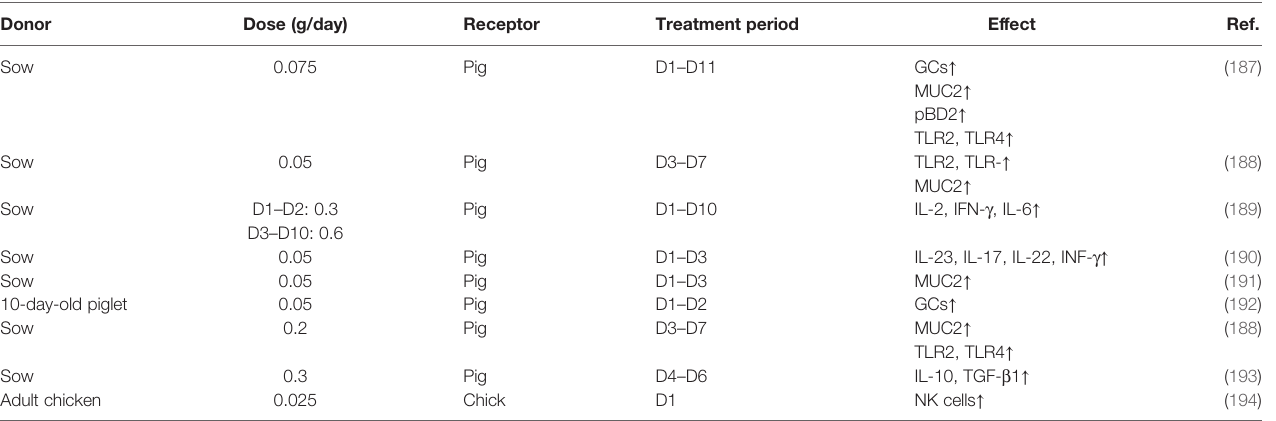
TABLE 3 | The effect of FMT on the intestinal innate immunity.